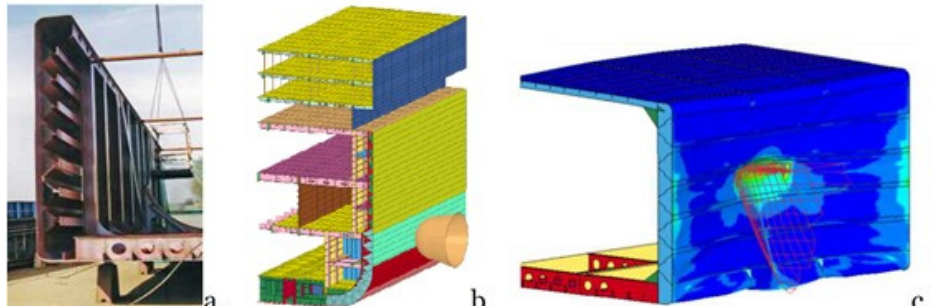
Figure 11. Concepts of crashworthy structures: ( a ) Longitudinal structure on-board an inland waterway gas carrier [37]; ( b ) Transverse structure on board a RoPax vessel, Ehlers et al. [42]; ( c ) Corrugated structure on board an inland waterway [42].